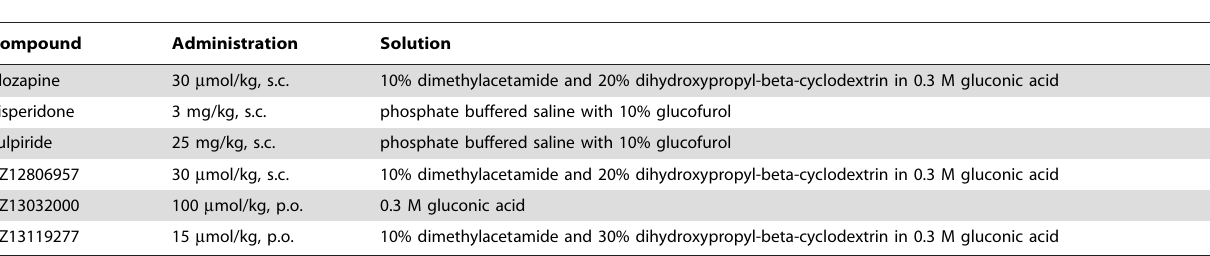
Table 1. Administration parameters used for brain microdialysis experiments.